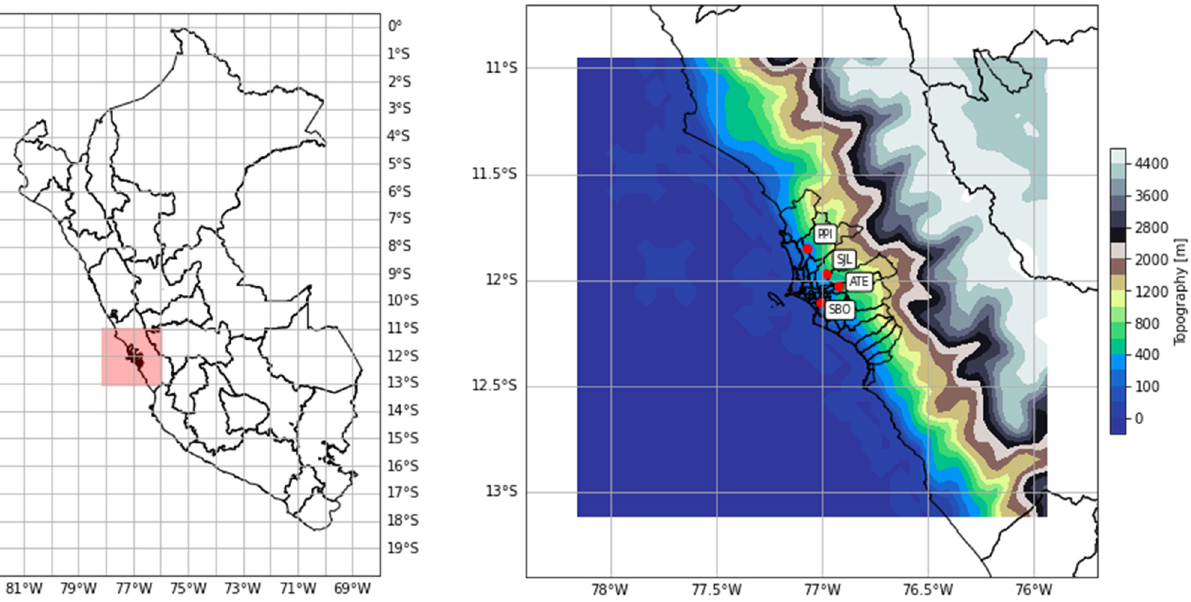
Figure 1. Map of the four automatic air-quality monitoring stations (AAQMS) in the MALC selected for this study. Namely, ATE, SBO and SJL illustrate the locations of the stations: ATE is Ate, SBO is San Borja, and SJL is San Juan de Lurigancho (SJL), which only recorded the PM 2.5 measurements; PPI is Puente Piedra, where both the meteorological variables and PM 2.5 measurements were recorded.